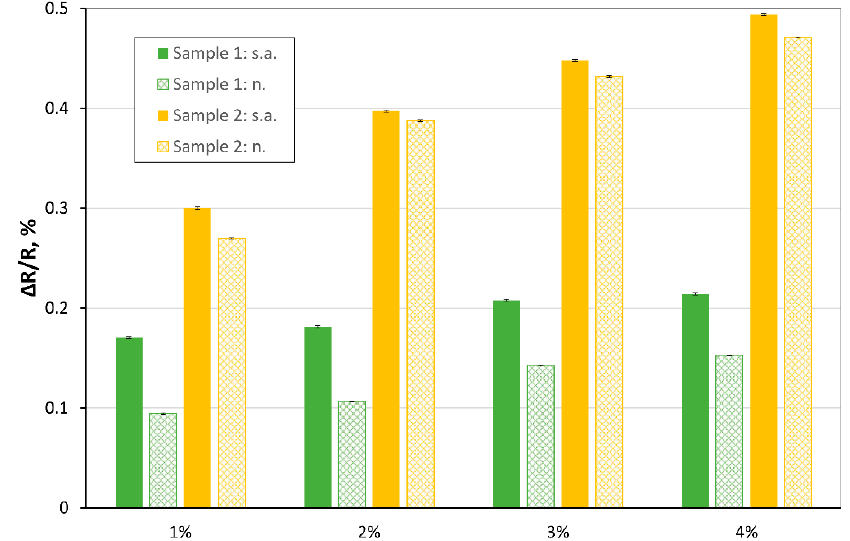
Figure 8. ∆ R calculated for various concentration of hydrogen in synthetic air (“s.a.”) and nitrogen (“n.”), temperature: 150 °C.